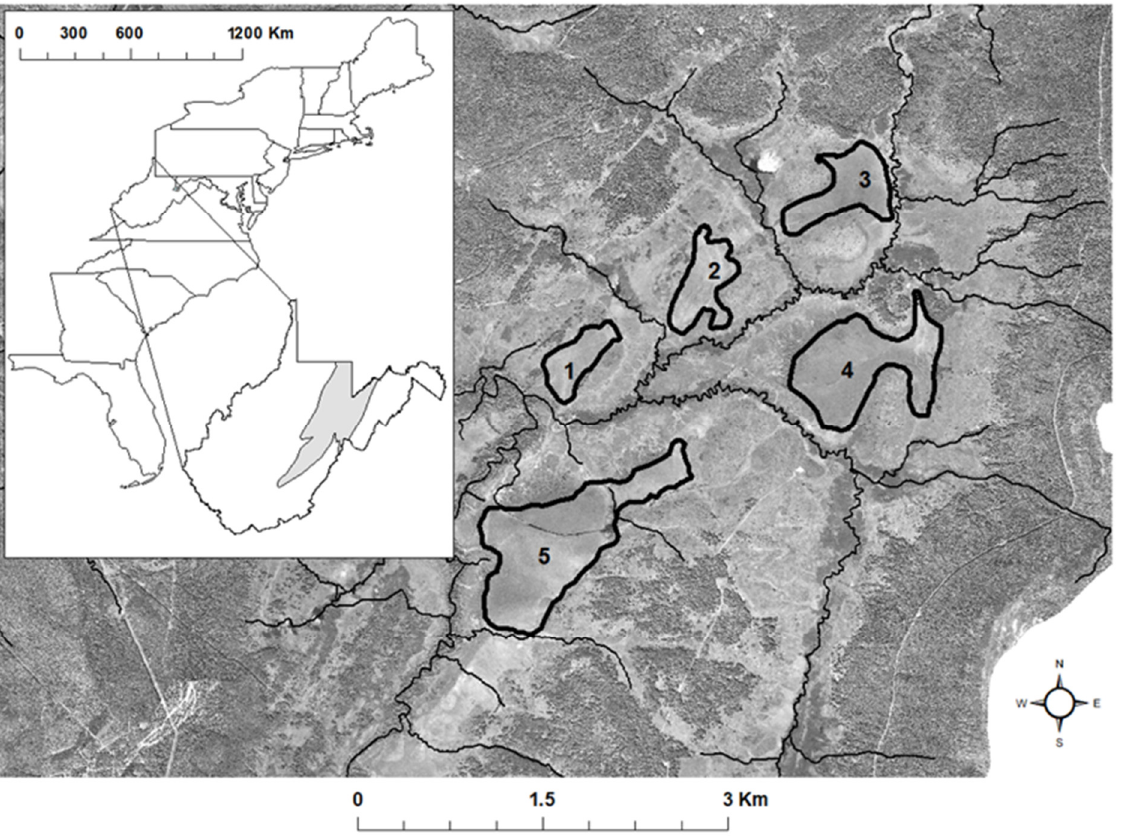
Figure 1. Location of Allegheny Mountain physiographic section (gray polygon) within West Virginia of the eastern United States. Aerial photograph of Canaan Valley National Wildlife Refuge including Peatlands 1 through 5. Aerial imagery obtained from the National Agriculture Inventory Program 2007 by United States Department of Agriculture.